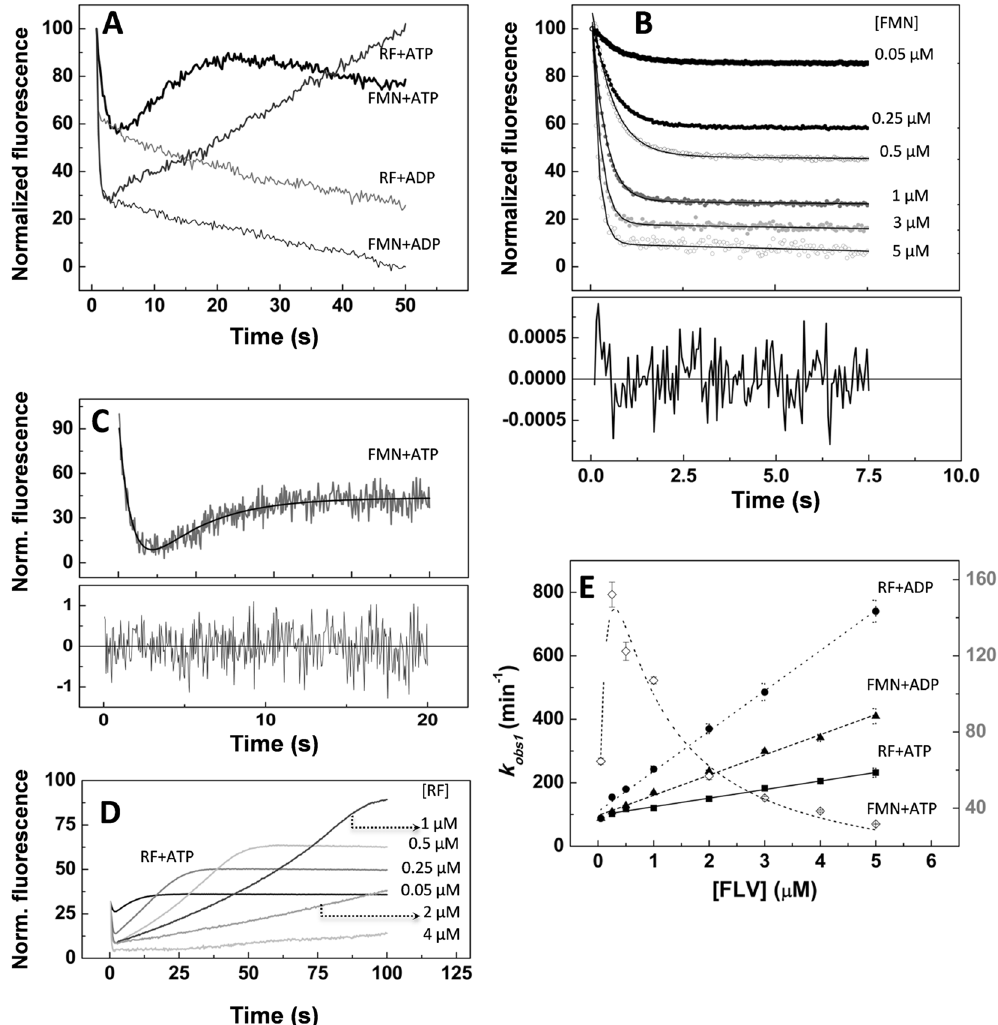
Figure 3. Pre-steady-state kinetic analysis of the binding of flavins to the RFK module of Ca FADS. ( A ) Kinetic traces of the evolution of flavin fluorescence upon mixing the RFK module (0.2 μ M) with RF (1 μ M) at saturating levels of ATP (250 μ M) and ADP (250 μ M) as well as samples of the RFK module with FMN (1 μ M) at saturating levels of ATP (250 μ M) and ADP (250 μ M). ( B ) Evolution of kinetic traces of FMN interacting with the RFK module in the presence of 250 μ M ADP at various FMN concentrations. Traces are fit to a mono- exponential decay with a steady-state component. Residuals of fitting the 1 μ M FMN data are shown at the bottom. ( C ) Dissection of the exponential processes for kinetic traces that were observed when the RFK module (0.2 μ M) containing a saturating level of ATP (250 μ M) was mixed with FMN (1 μ M). The panel shows the fit to a bi-exponential process, and the fitting residual is shown at the bottom. ( D ) Traces obtained when mixing the RFK module (0.2 μ M) containing a saturating level of ATP (250 μ M) with different RF concentrations. ( E ) Evolution of k obs1 as a function of the flavin concentration for the mixing of the RFK module with RF + ADP ( ● ), FMN + ADP ( ▲ ), RF + ATP (RFK reaction, ■ ) and ( C ) FMN + ATP ( ◊ ). For those data showing linear dependences, the slopes are related to the k on for the binding, and the independent term is associated with the k off . All the experiments were carried out in the stopped-flow equipment at 25 °C in 20 mM PIPES and 0.8 mM MgCl 2 , pH 7.0. All concentrations that are indicated are final concentrations in the mixing